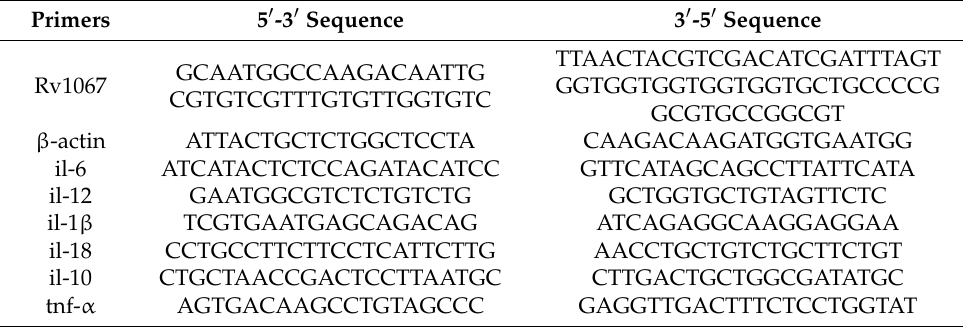
Table 1. Primers sequences used in this article.